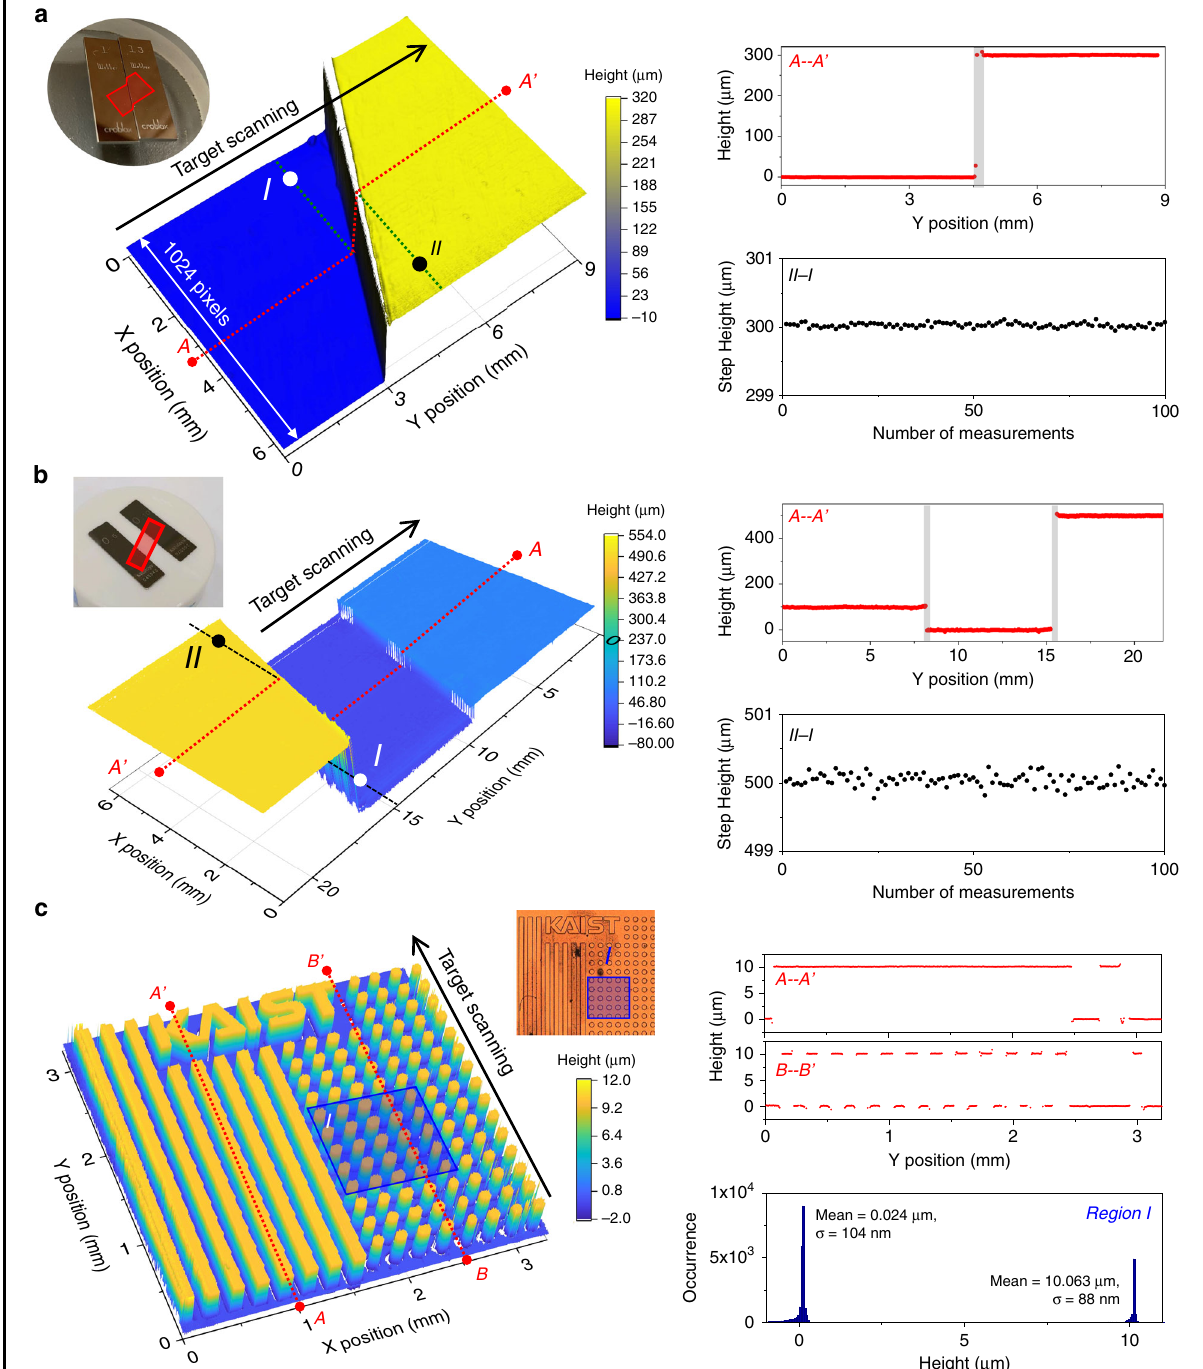
Fig. 3 3D surface pro fi le imaging results. a Surface pro fi le imaging of two gauge-blocks of the same material (chromium carbide). As shown in the cross-sectional view from point A to A ’ , the 300- μ m step height is clearly measured. The grey regions indicate the edge of the gauge blocks, where TOF has ambiguity due to re fl ections from two surfaces. The step height (between points I and II ) is determined to be 300.029 μ m with repeatability (the standard deviation value of 100 consecutive measurements at 100- μ s acquisition time) of 31nm and error of + 31nm from a calibrated interferometer result. b Imaging results of different materials assembly; two steel gauge blocks attached on a ceramic optical fl at. The measured 500- μ m step height ( II - I ) show 93-nm repeatability (100- μ s acquisition time) and − 22nm error from a calibrated interferometer result. c Surface pro fi le imaging of a complicated periodic structure (silicon sample coated with 100-nm-thick silver). A pair of f = 60mm lenses are used for better spatial resolution. A histogram of TOF points in region I shows 10.039 μ m mean height difference, which has − 14nm error from a confocal microscopy result. Inset: microscopic image (2.5X) of the